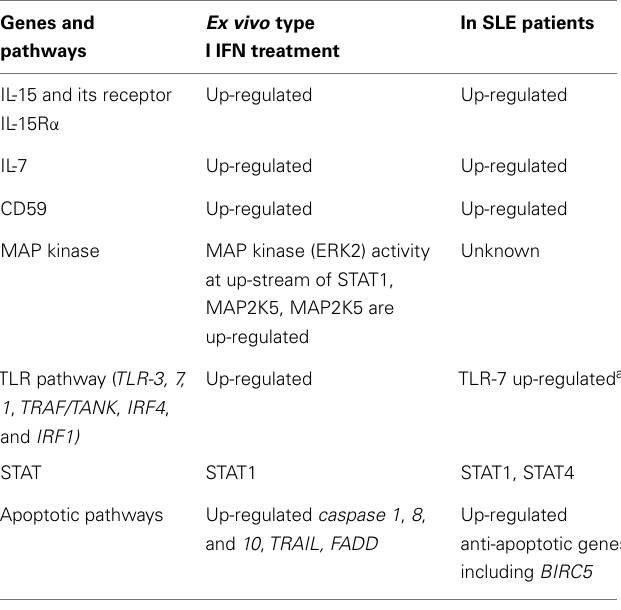
Table 1 | Results from computational pathway analysis of microarray data sets.